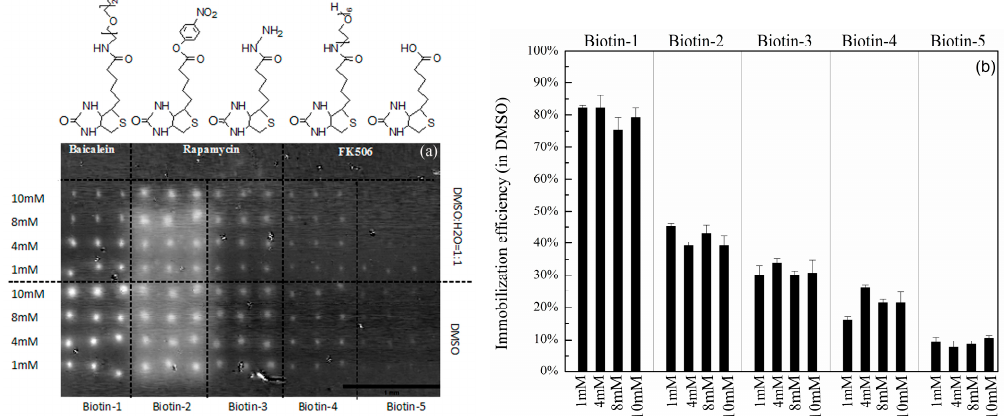
Figure 2. ( a ) After reaction with anti-biotin antibody, the change in OI-RD image (differential OI-RD image) of a biotinylated compound microarray on hexyl-isocyanate functionalized slide with (PEG) 6 and catalyzed in pyridine vapor at room temperature; ( b ) Extracted immobilization efficiencies of five biotinylated compounds with different nucleophilic residues available for surface anchoring.